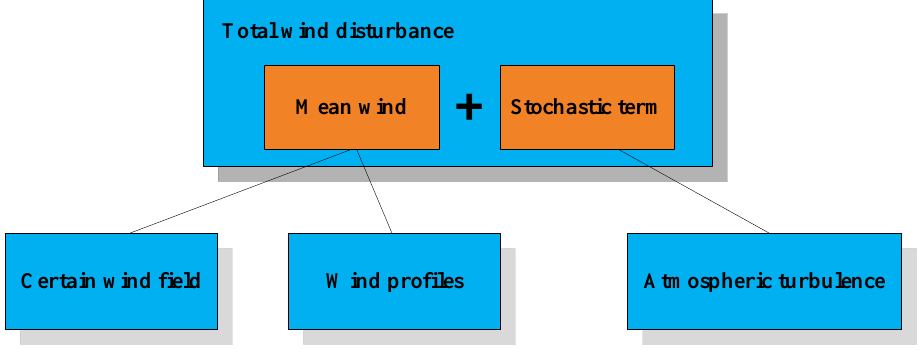
Figure 16. Composition of the wind disturbance in small time and spatial